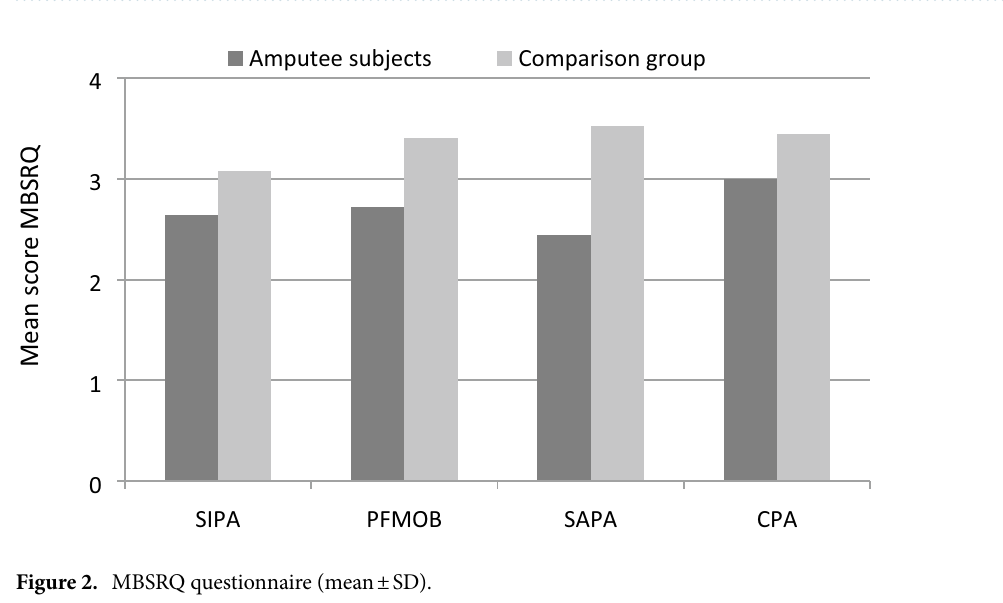
Figure 2. MBSRQ questionnaire (mean ±